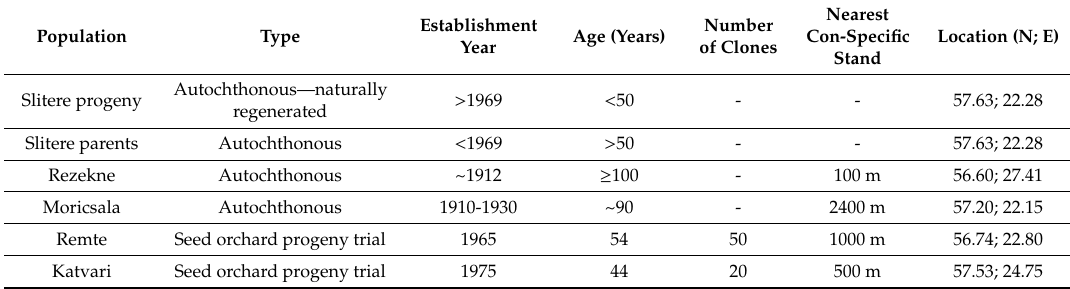
Table 1. Summary of analyzed populations.